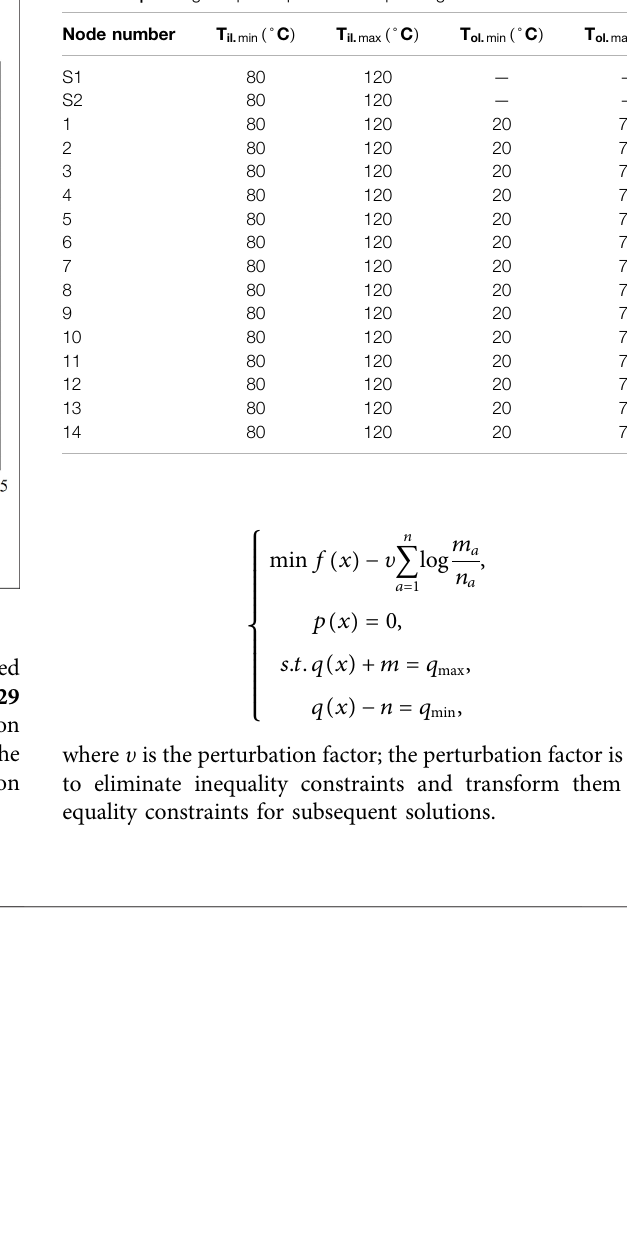
TABLE 3 | Setting of optimal power fl ow operating conditions.